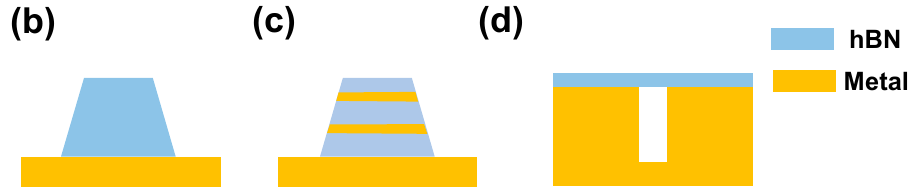
Figure 8. Unit cells of hBN-based metasurface absorbers/emitters (MAEs): ( a ) rectangular hBN/metal, ( b ) trapezoidal hBN/metal, ( c ) multilayer hBN/metal, and ( d ) hBN with plasmonic nanostructure grating.